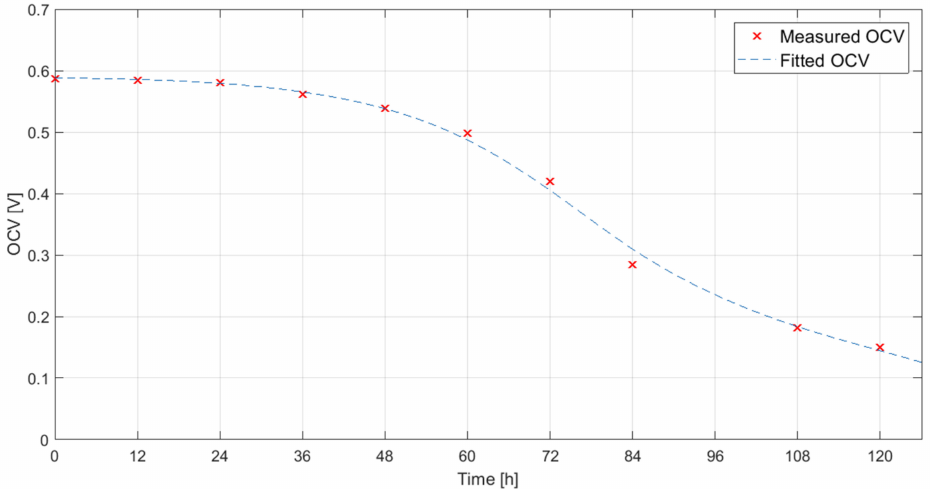
Figure 6. Open circuit voltage measurement of the studied EBC. Gathered data are represented in red crosses, fitted OCV evolution in blue dashed line.